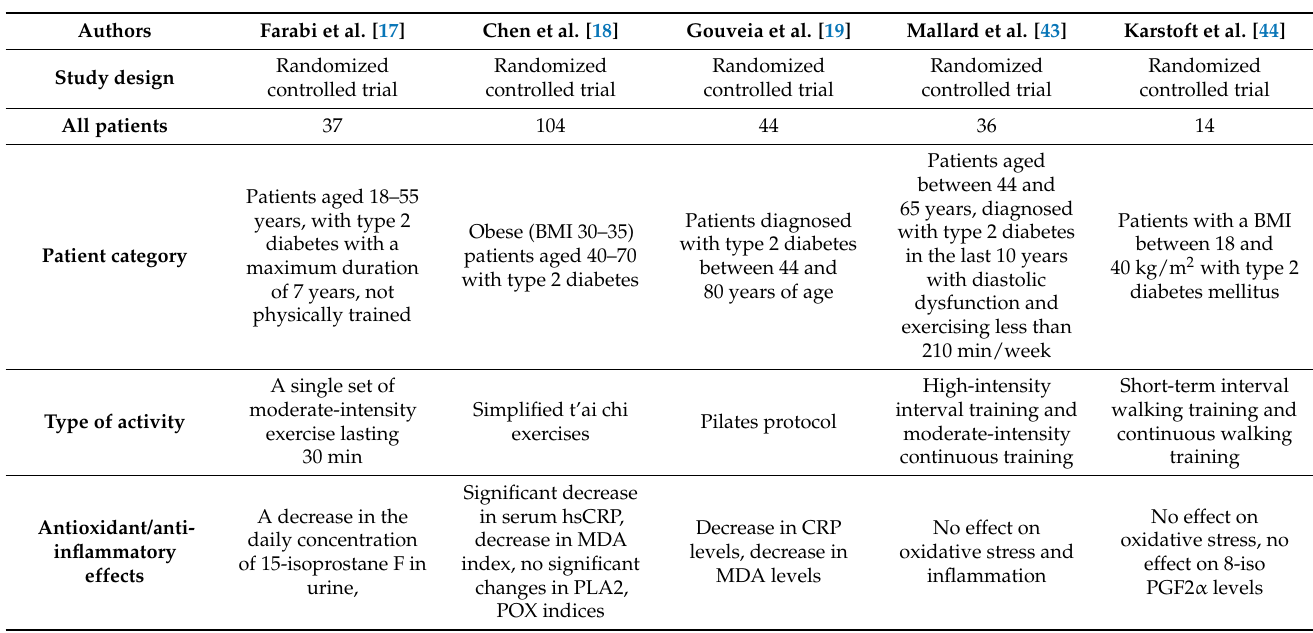
Table 1. Effects of Specific Activities on Oxidative Stress and Inflammation